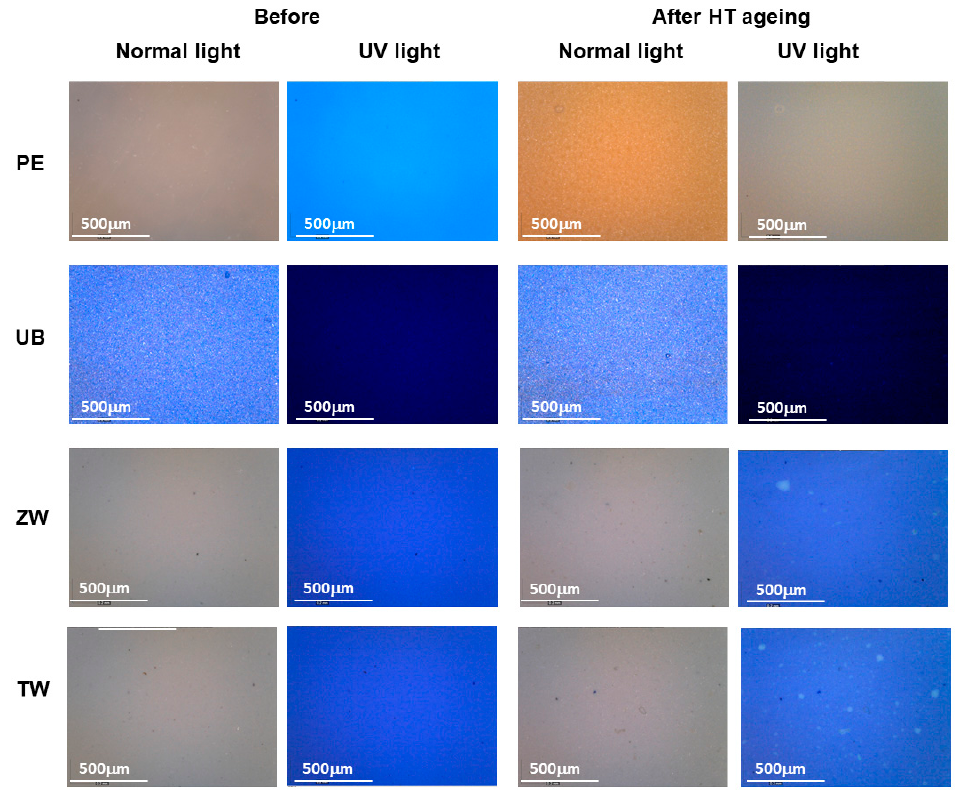
Figure 4. Microscopic observation of the mock-ups in normal and UV light before and after high temperature treatment: Unpigmented Edelwachs (PE), ultramarine blue (UB), zinc white (ZW) and titanium white (TW).